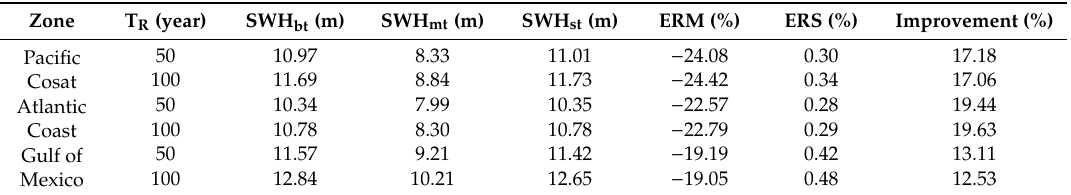
defined in Section 2.2 for the three areas and two (50 and 100 years) return